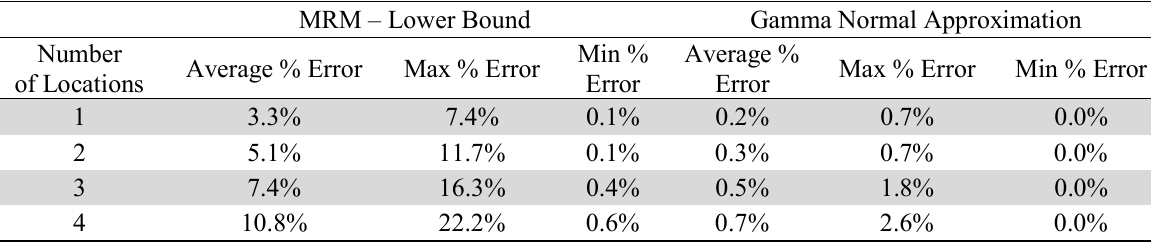
(𝑇|𝑁 ) for an unreliable part (cid:3036) (cid:3036)